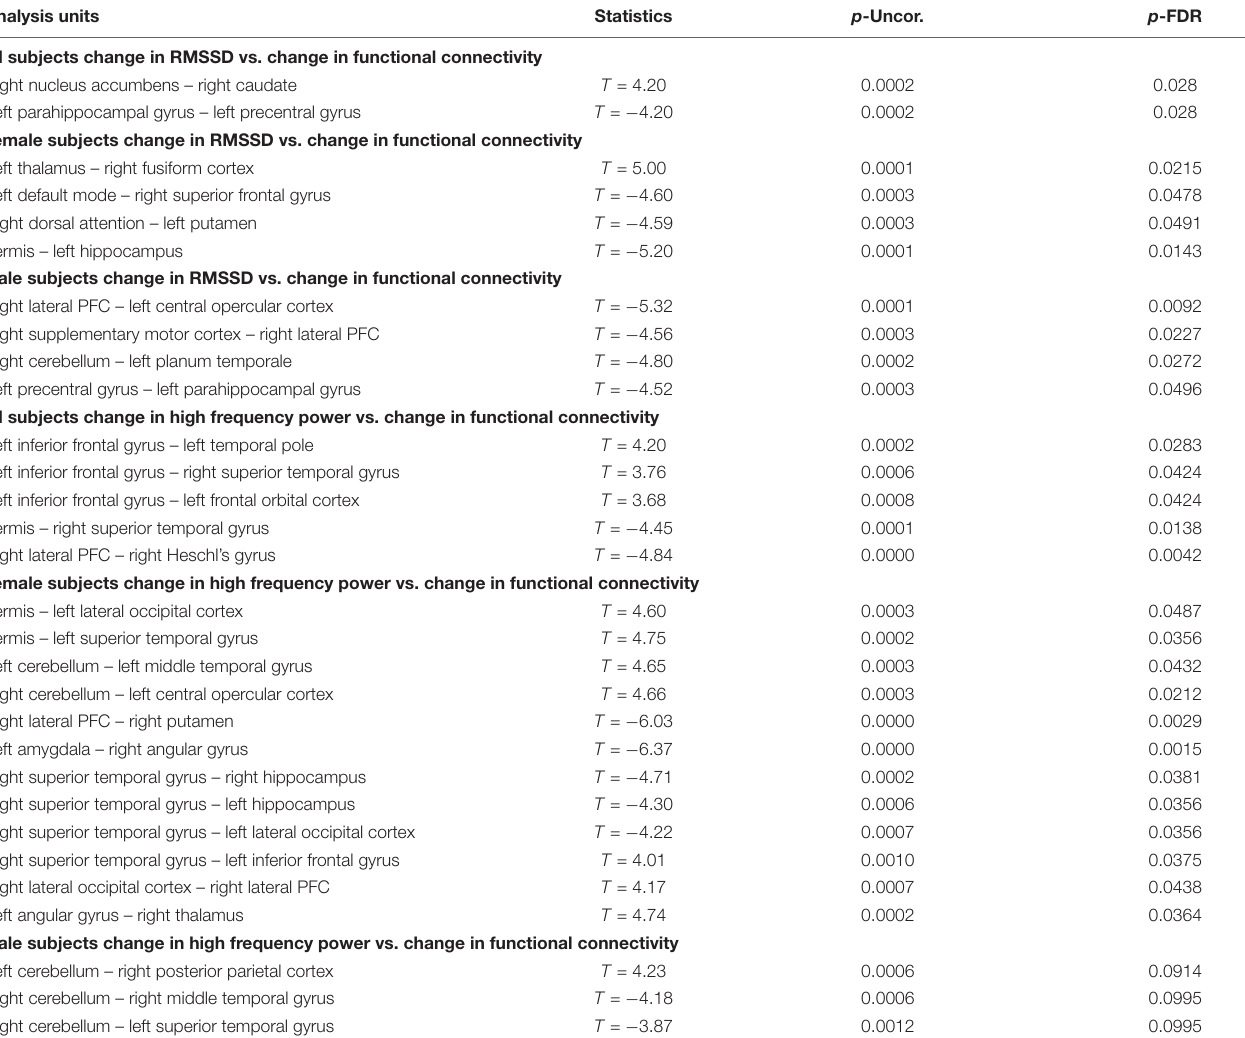
TABLE 4 | Correlation between functional connectivity differences and heart rate measures (RMSSD and high frequency power) showing the uncorrected p value (p-Uncor.) and False Discovery Rate corrected p -value (p-FDR). Analysis